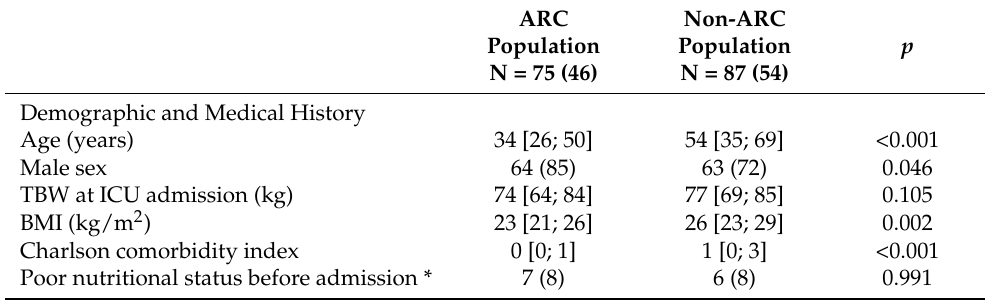
Table 2. Patient characteristics compared in ARC vs. non-ARC